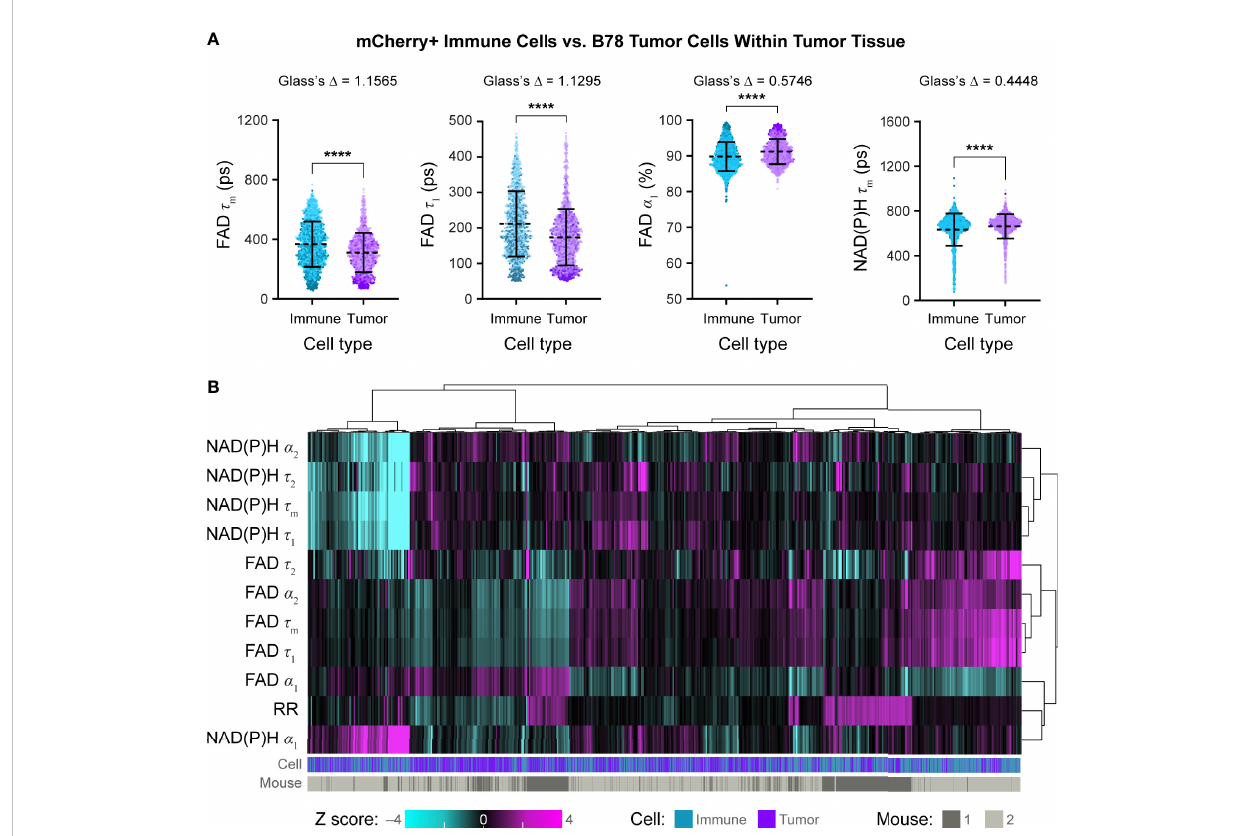
FIGURE 6 In vivo optical metabolic imaging within tumors discriminates in fi ltrating immune and tumor cells. (A) Single cell OMI parameters from in fi ltrating mCherry+ immune cells (n = 1688 cells) and B78 tumor cells (n =1455 cells) within the tumors from n = 2 mice. Immune cells from the B78 tumors exhibit signi fi cantly increased FAD t m (361 ps vs. 306 ps) and FAD t 1 (213 ps vs. 174 ps) compared to B78 tumors cells (Glass ’ s D > 0.8). Immune cells from B78 tumors exhibit decreased FAD a 1 (89% vs. 91%) compared to B78 tumor cells; though the p value indicates substantial signi fi cance (p<0.0001), only a trend is observed using the more conservative Glass ’ s D test (Glass ’ s D = 0.5746). Immune cells from B78 tumors exhibit decreased NAD(P)H t m (667 ps vs. 686 ps) compared to B78 tumor cells; though the p value indicates substantial signi fi cance (p<0.0001), only a trend is observed using the more conservative Glass ’ s D test (Glass ’ s D = 0.4448). Data points colored to re fl ect individual replicates acquired on different days. Bars indicate mean ± SD, Mann-Whitney U Test, ****p<0.0001 shown for reference; all Mann-Whitney U Test comparisons are signi fi cant due to the large sample size so Glass ’ s D was also used as a more conservative signi fi cance test, see Methods. (B) Heatmap of z-scores of 12 OMI parameters from immune cells and tumor cells within B78 tumors. Hierarchical clustering of single cells indicates data clusters best by mouse with some clustering by cell type. Each column is a single cell (n = 3143